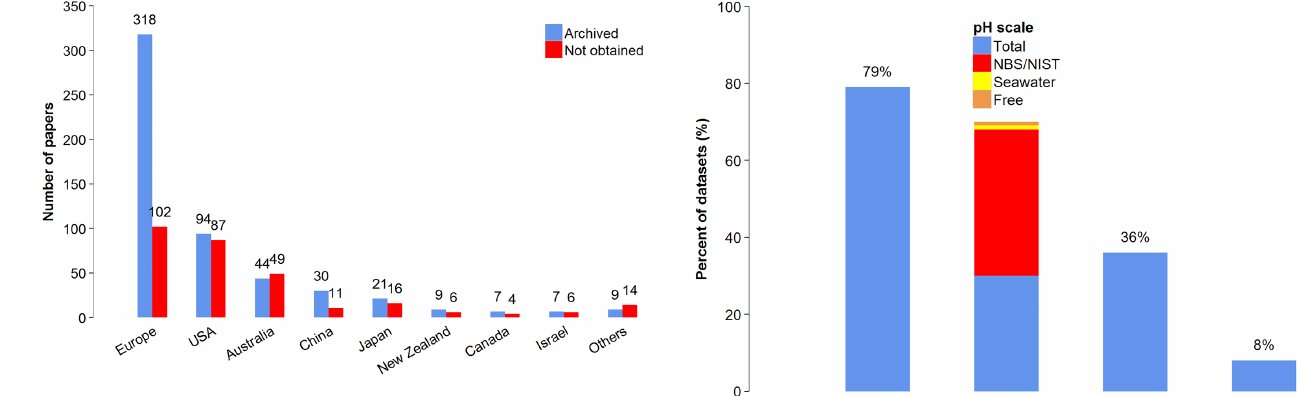
Figure 6. Countries of affiliation of first author of papers from which data were archived and papers for which data could not be obtained.